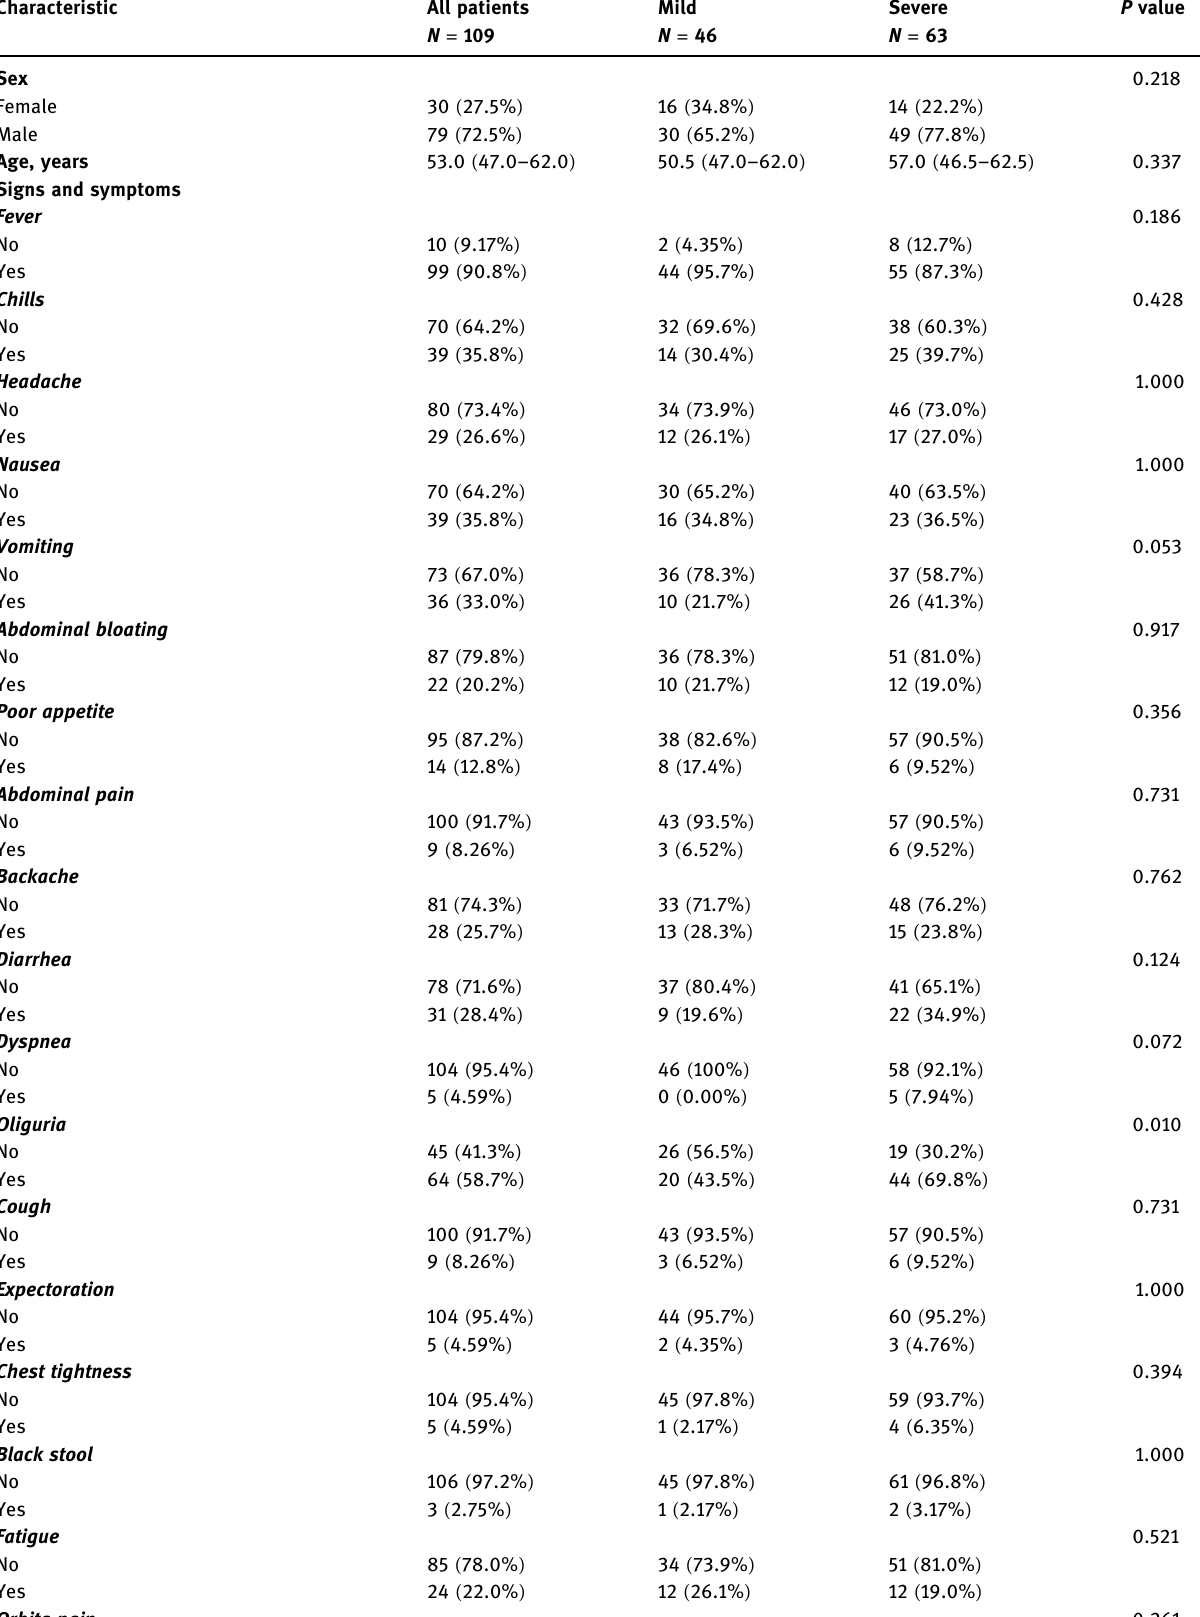
Table 2: Demographic and clinical features of patients with HFRS in the training cohorts